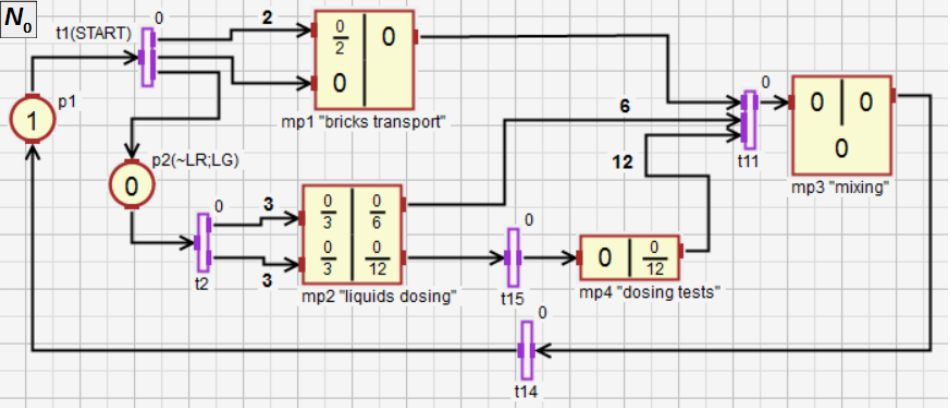
Figure 12. The main subnet of the control algorithm in the form of HFIPN